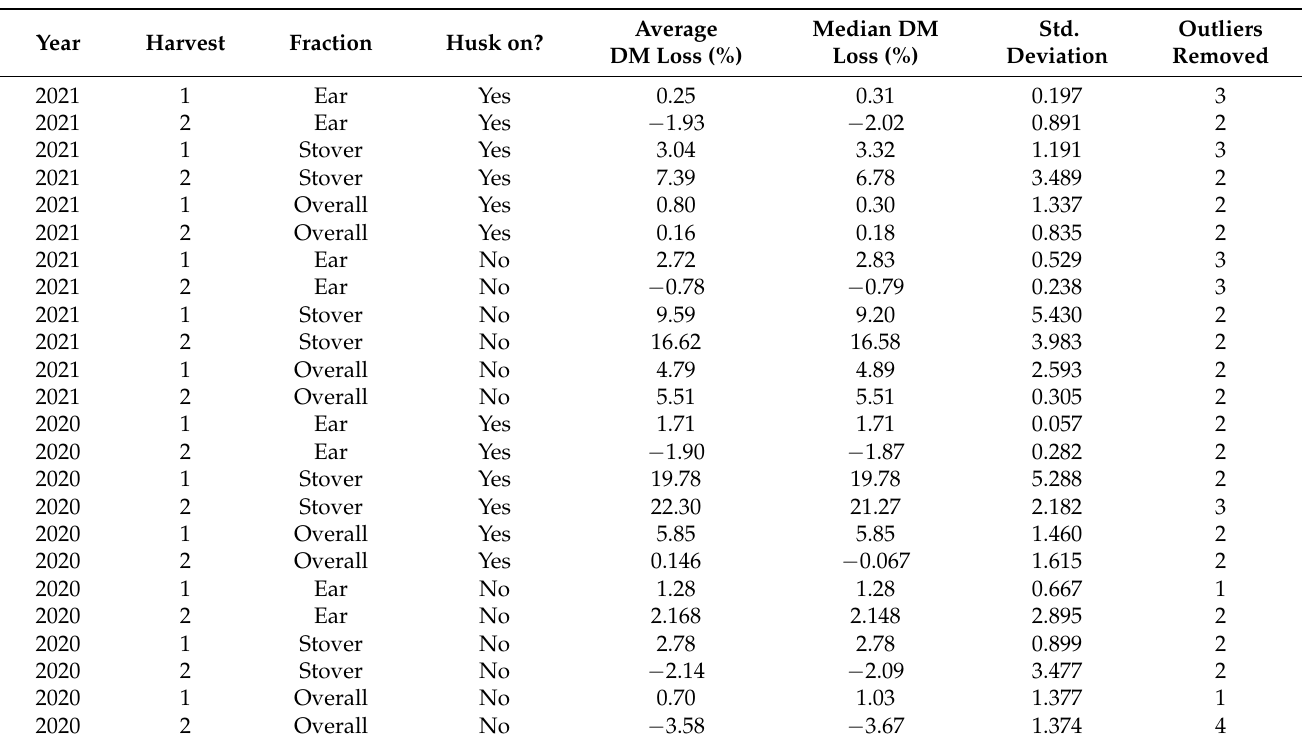
Table 2. Descriptive statistics for dry matter loss of ear, stover, and whole plant biomass. Averages were reported after cleaning outliers from the data.